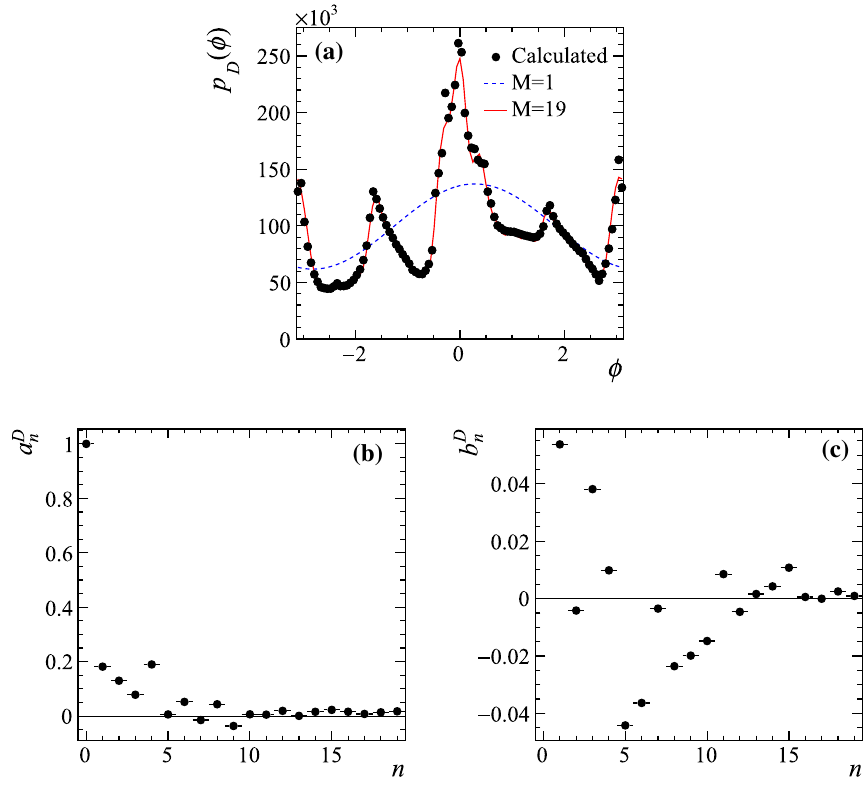
Fig. 1 a The function p D (φ) according to a model obtained by the Belle collaboration [14]. The points are the histogram of φ = (cid:8)( z ) values calculated for the generated sample of π + π − flavour-specific D → K 0 S decays, solid red line is the result of Fourier expansion with M = 19, and dashed blue line is a single harmonic ( M = 1). b , c Fourier series coefficients, calculated from the p D (φ) density